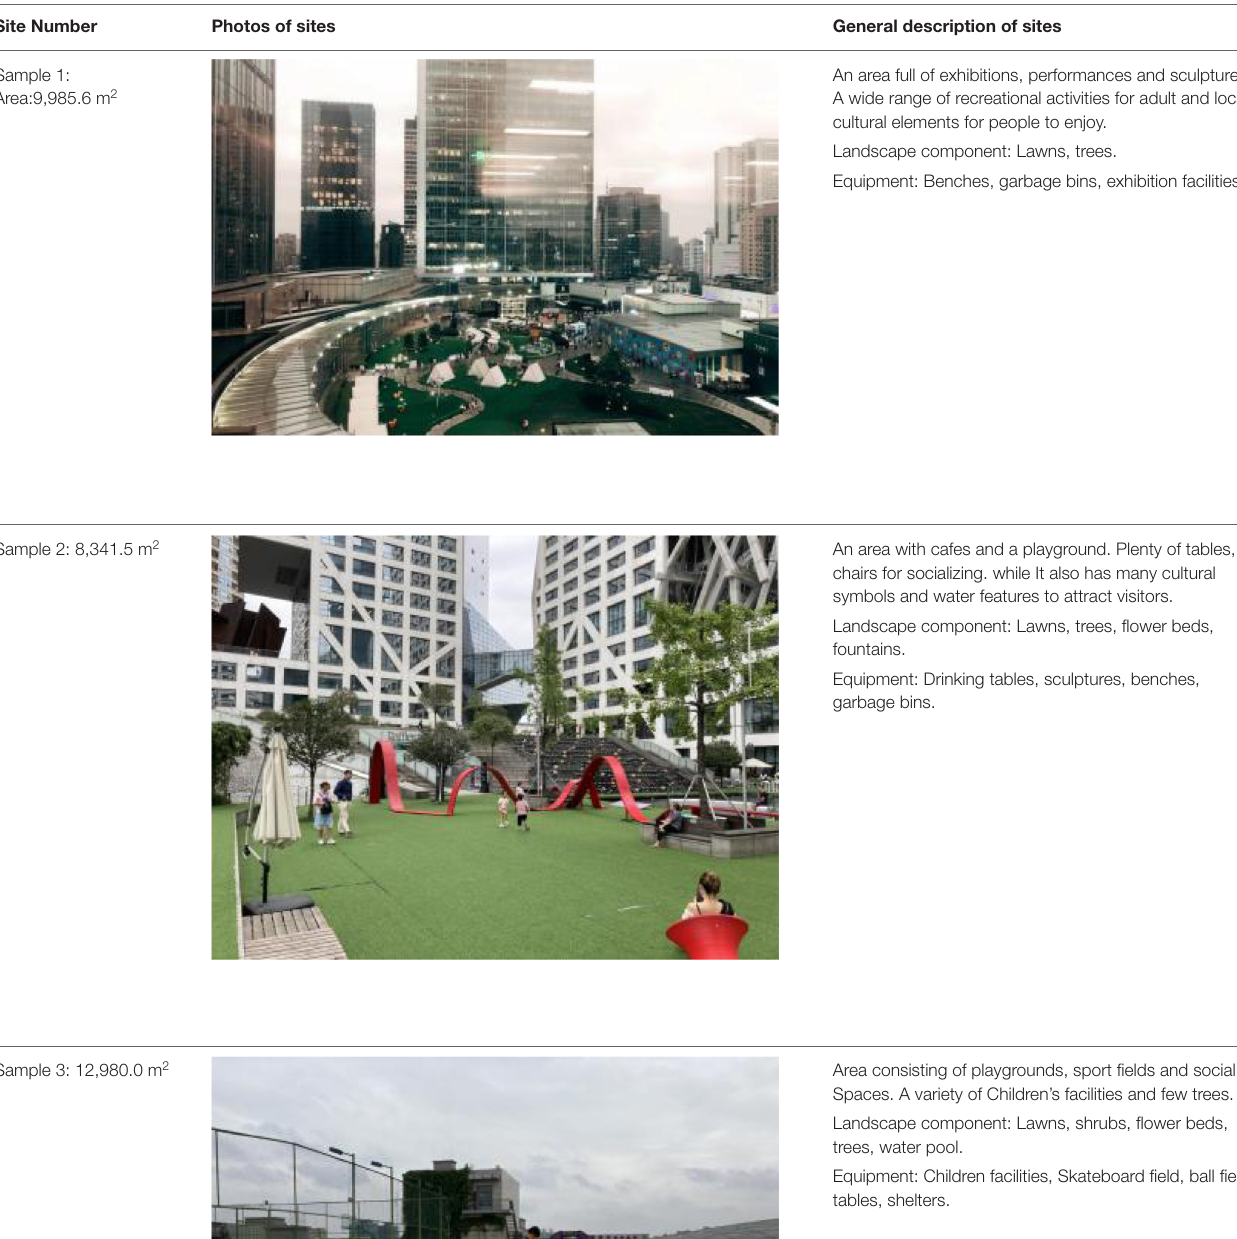
TABLE 2 | The samples of Public rooftop gardens in Chengdu (Source: All photos taken by first author unless otherwise